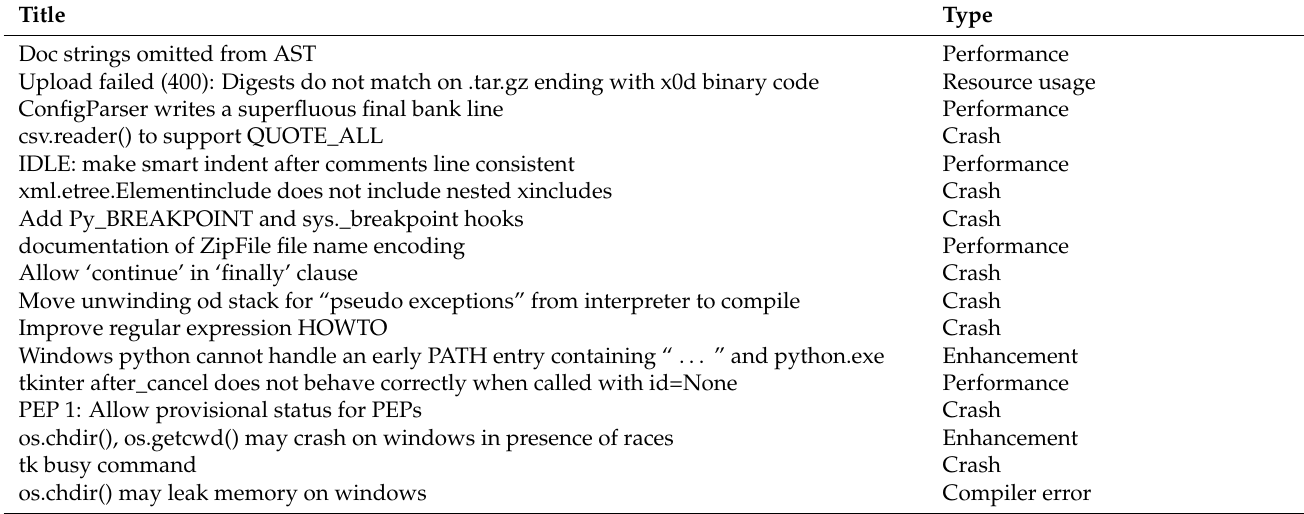
Table 2. Types of bug.